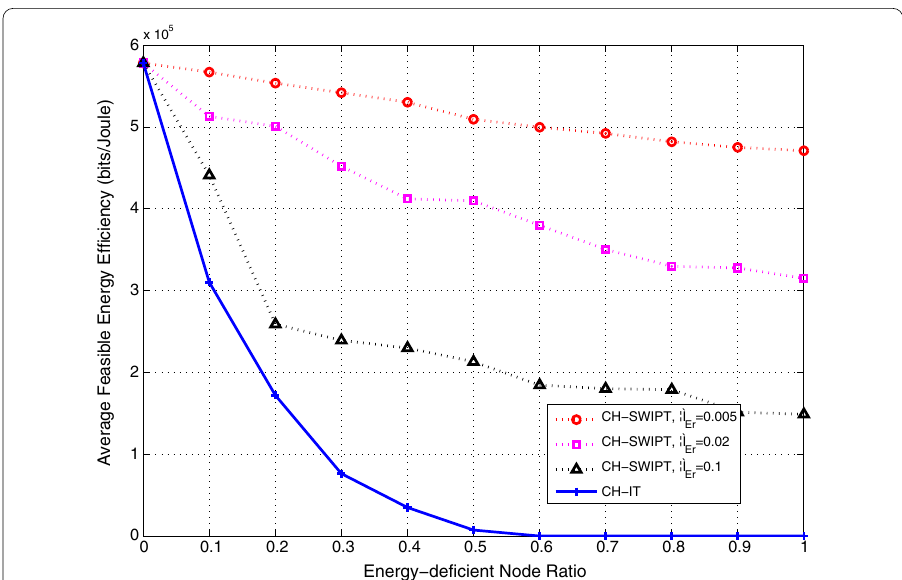
Fig. 10 Average feasible energy efficiency versus the energy‑deficient node